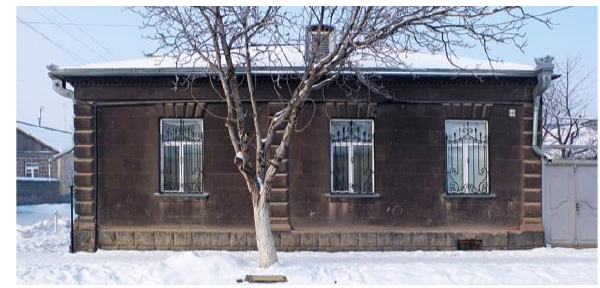
Figure 16. Gukasyan Street, 146. Photo by the author, 2018.